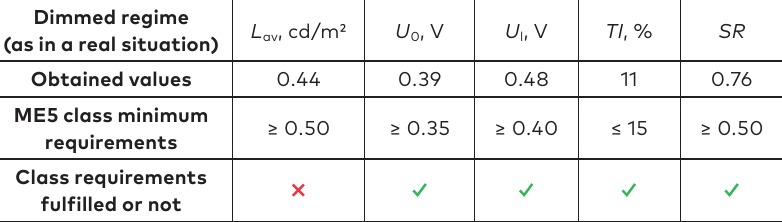
Table 4. The main parameters of two LED luminaries tested in Incukalns city in-situ in 2012 Table 5. Dialux modelling results of PLAZA L70 LED luminary